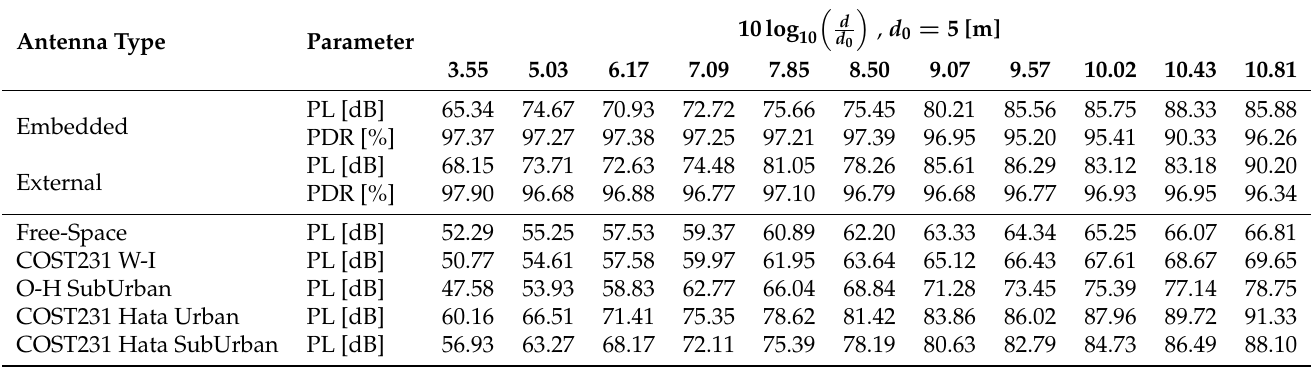
Table 7. Measured average path loss and Packet Delivery Ratio for Non-Line-of-Sight scenario (one turn).